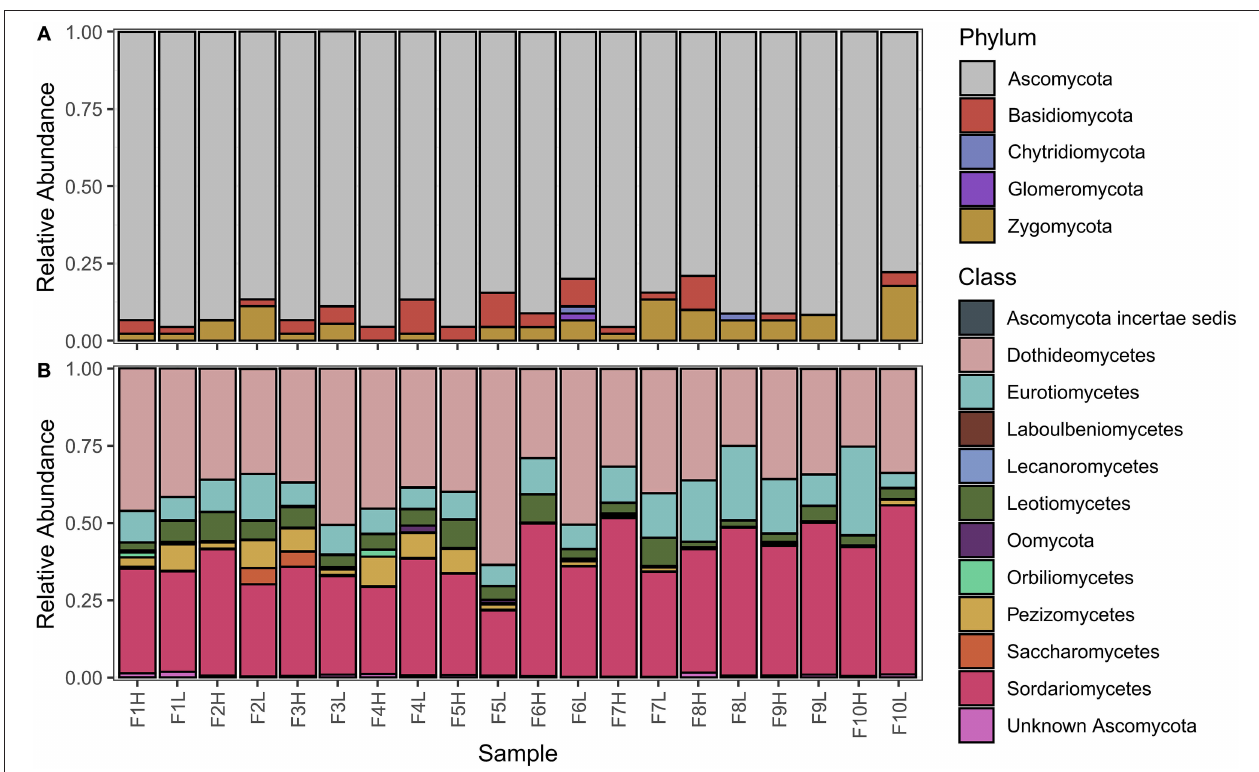
FIGURE 5 | Average relative abundances of corn root fungi communities across all farms. Relative abundance of fungal communities at the (A) phylum level (ITS2 general fungal primer), and the (B) class level (LSU Ascomycota specific primer).